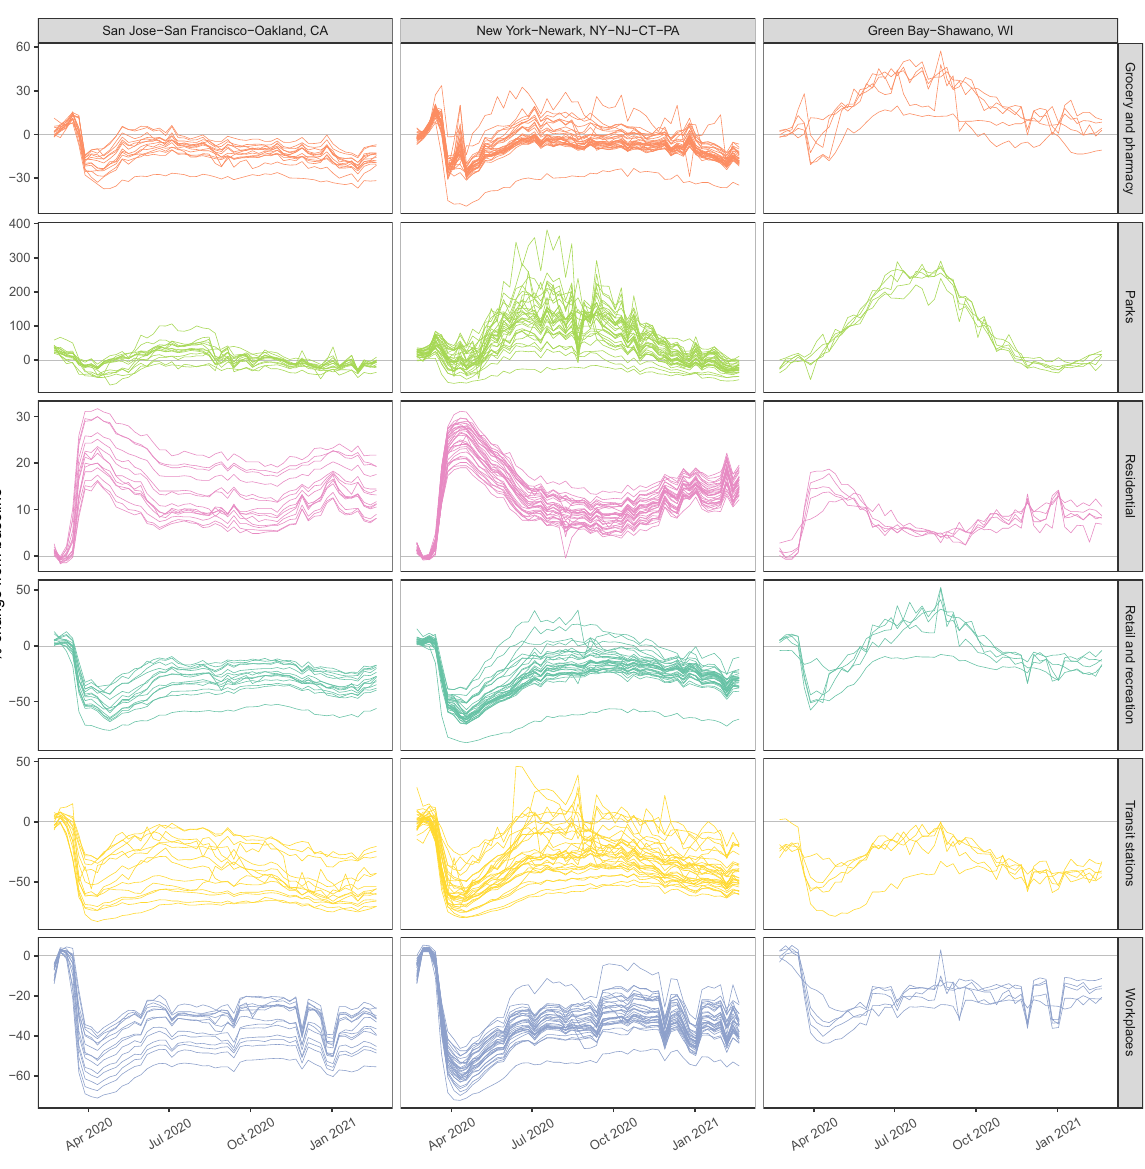
Fig. 2 Illustrative county-level mobility. County-level weekly % change from baseline mobility for six mobility categories (grocery and pharmacy, parks, residential, retail and recreation, transit stations, and workplace) are shown for three to confusing conclusions. Each column of Fig. 3 highlights a different type of pitfall that can occur when the models under consideration are not properly constrained. The top row of the fi gure plots speci fi c predictor variables (e.g., temperature or mobility) of interest. The middle row shows the estimated coef fi cients learned by a model for the variables in the top row. The bottom row shows the observed and fi tted (i.e., predicted) values from the model. The left column (labeled “ collinear ” ) of Fig. 3 illustrates an issue caused by collinear input predictor variables. It is tempting to include each of the Google mobility types as separate variables in a model that predicts weekly infection growth rates from covariates such as mobility. However, the strong correlations between the different mobility variables often lead to misleading estimated associations between distinct mobility variables and infection growth rates. The top-left pane of the fi gure displays the